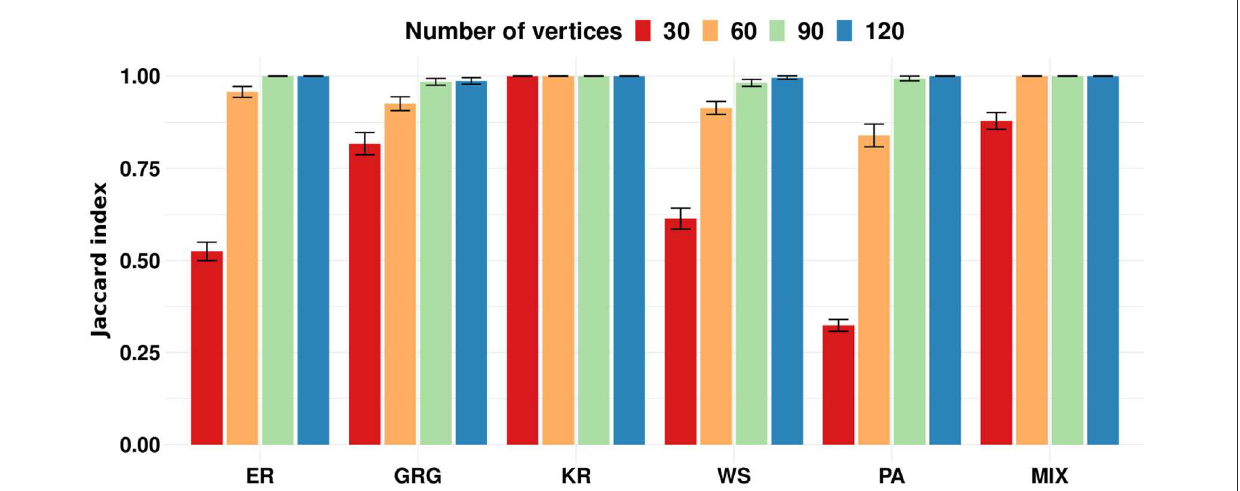
FIGURE2 Each group of bars represents a scenario of simulation 1 repeated 100 times for graphs’ sizes 30, 60, 90, and 120. The scenarios are composed of the following random graph models: Erdös-Rényi (ER), geometric (GRG), k-regular (KR), Watts-Strogatz (WS), Preferential Attachment (PA), and a mixture of geometric, k-regular, and preferential attachment random graph models (MIX). The y-axis represents the average Jaccard index. Error bars represent 95% confidence intervals. The proposed k-means performs better as the graph size